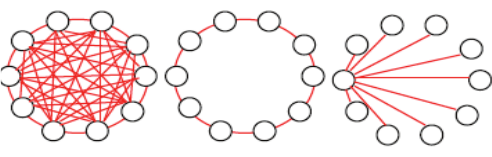
Fig.4. Particle topology in PSO